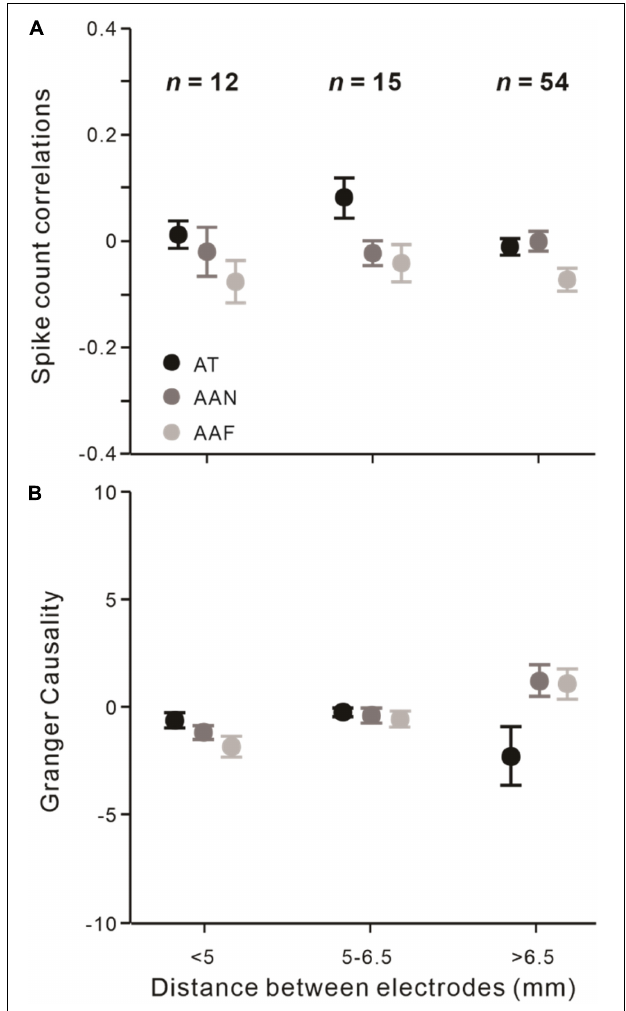
FIGURE 5 | Effects of the distance between recording electrodes among different attentional conditions. (A) Effects of different electrodes distances on r sc . (B) Same as (A) but analyzed on Granger causality. Error bars represent ± SEM. Repeated-measures